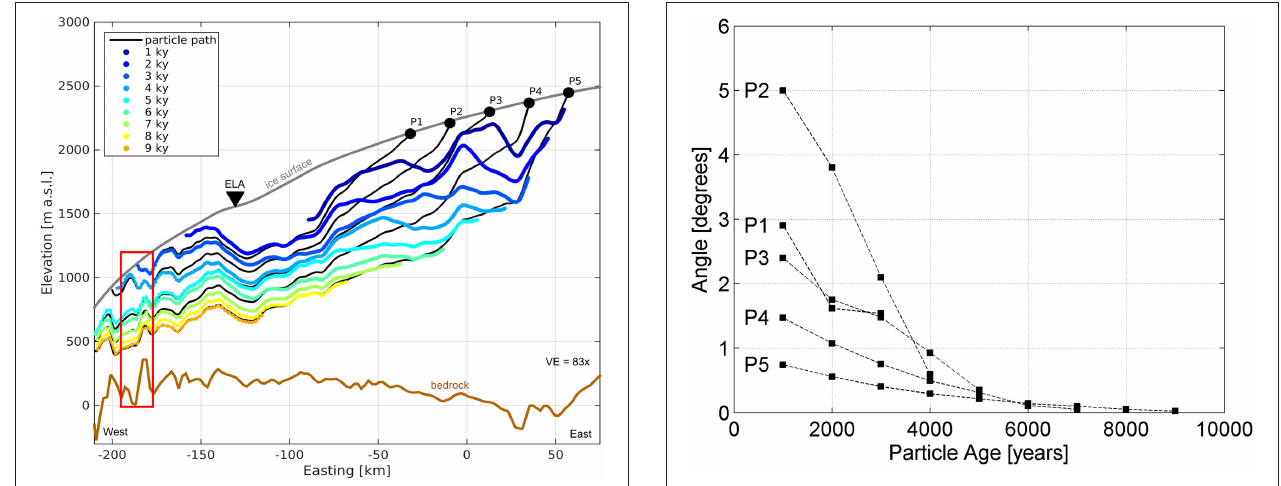
FIGURE 4 | Simulation results. Simulated isochrones (colored lines: blue to orange, youngest to oldest) and particle paths (black lines) are shown from burial in the accumulation zone to emergence in the ablation zone. Note that due to the aspect ratio, vertical motion is exaggerated 83x. Ice surface (gray line), bed (brown line), and the ELA (black triangle) are also shown. The extent of Figure 7 is indicated (red box). There is a third dimension (Northing) to these results which is not shown here.